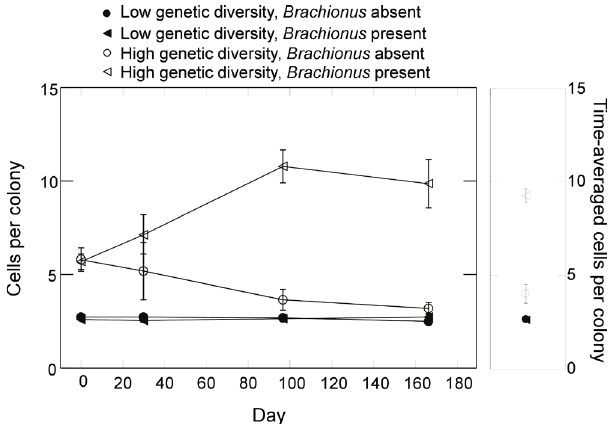
Figure 8. Effects of Synura genetic diversity and Brachionus presence/absence on the mean number of cells per Synura colony. The left panel displays dynamics over time and the right panel time-averaged values (averaged over days 30 to 167). Shown are means (+/-